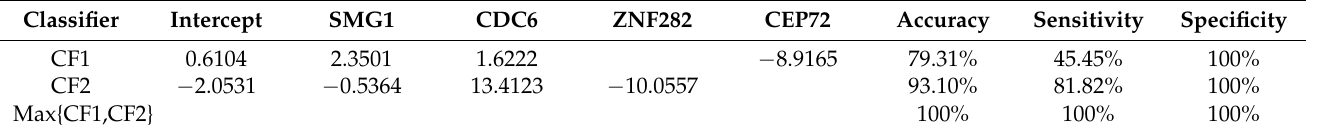
Table 15. GSE177477: Characteristics of the top-performing four-gene classifier. CF1 and CF2 are the first and second individual classifiers for data of COVID-19 patients vs. healthy